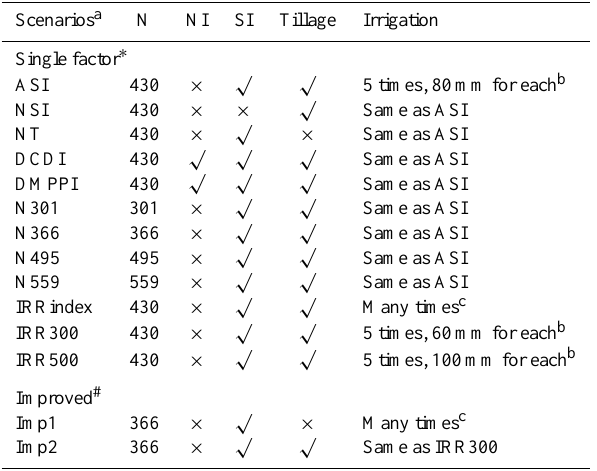
Table 2. Detailed management practices for each